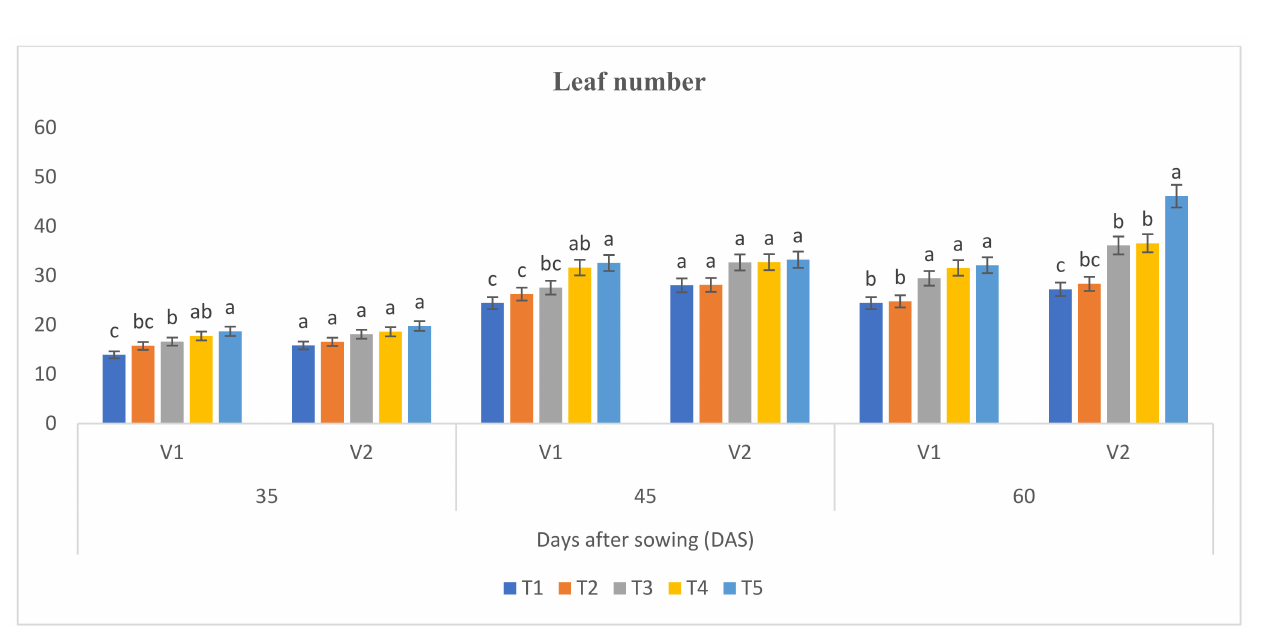
Figure 3. Effect of hydro, Mg(NO 3 ) 2 , ZnSO 4 , Mg(NO 3 ) 2 + ZnSO 4 primed, and nonprimed (control) seed treatments on leaf number of wheat varieties, grown in the year 2017–2018. The full description of abbreviations T1, T2, T3, T4, T5, V1 and V2 are represented in material and methods section. Lowercase alphabetical letters (a,b,c) represents the significant differences between the different seed priming treatments (Tukey test; p <